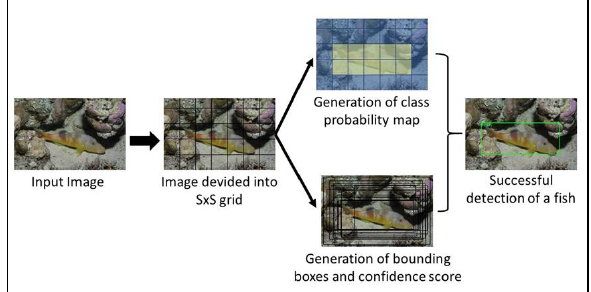
Figure 1 . Yolov3 architecture.